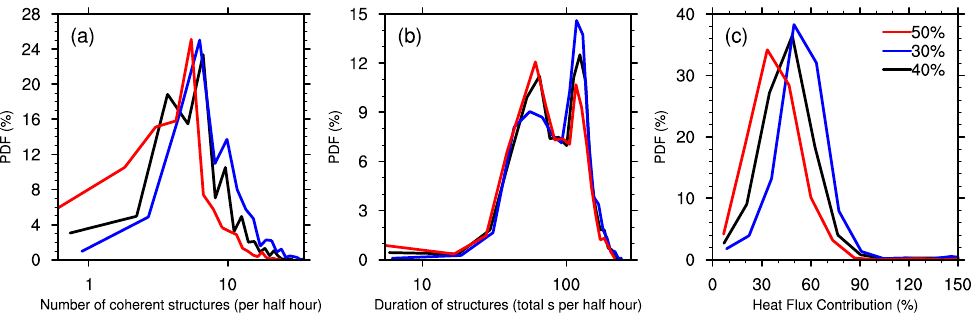
Figure B2. Sensitivity analysis of wavelet technique to the wavelet power spectrum threshold criteria of 40% (black; used in the paper analysis), 30% (blue) and 50% (red) for the (a) number of coherent structures, (b) duration of structures, and (c) percent contribution to kinematic heat flux.